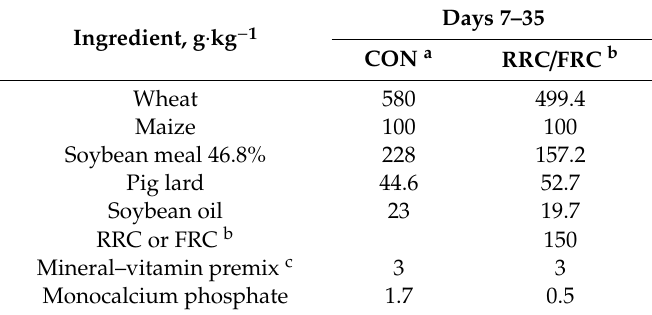
Table 1. Composition and nutritive value of diets in experiments 1, 2, and